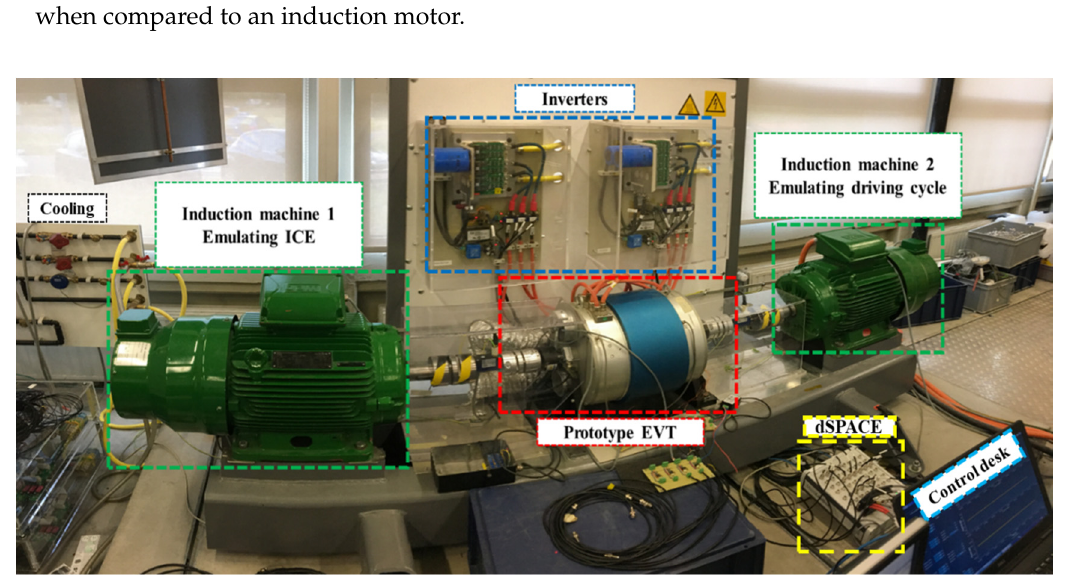
Figure 13. Experimental test bench of the study.